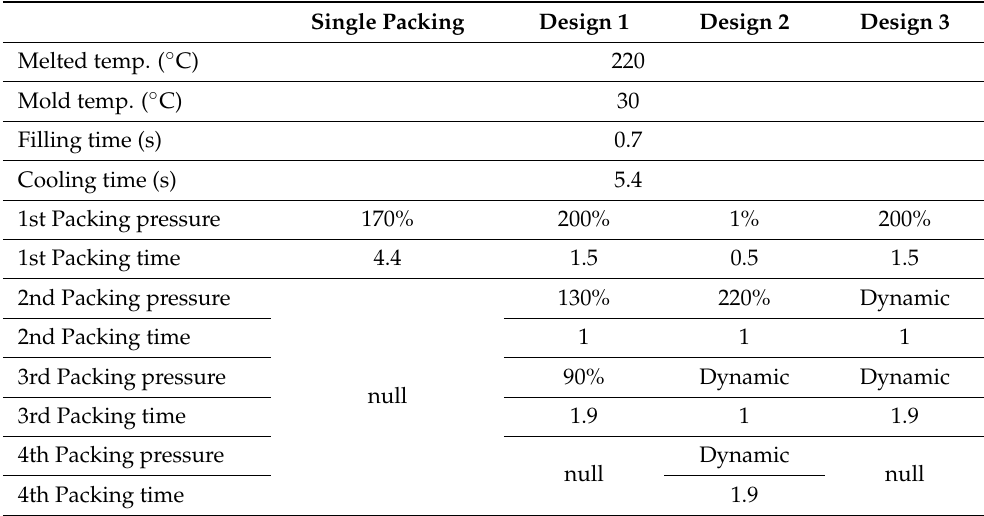
Table 1. Experimental parameters. Single Packing Design 1 Design 2 Design